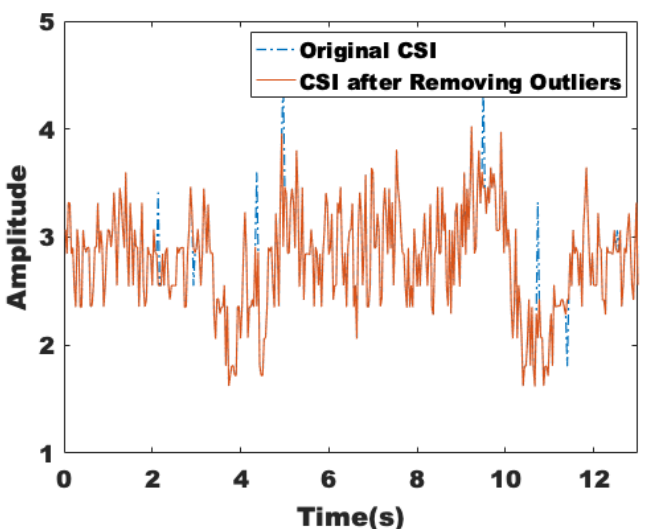
Figure 7. The CSI after removing